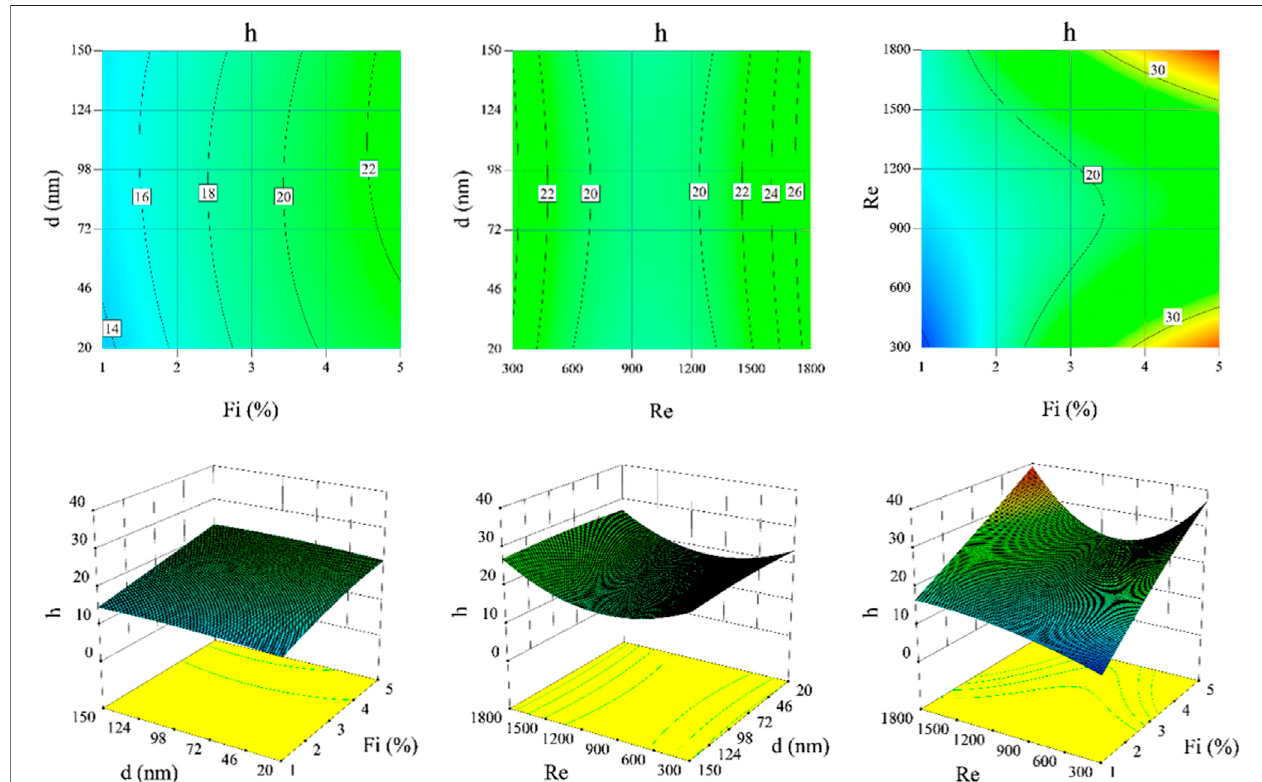
FIGURE 7 | Increase in percentage in the HTC for different values of Re , d , and Fi .